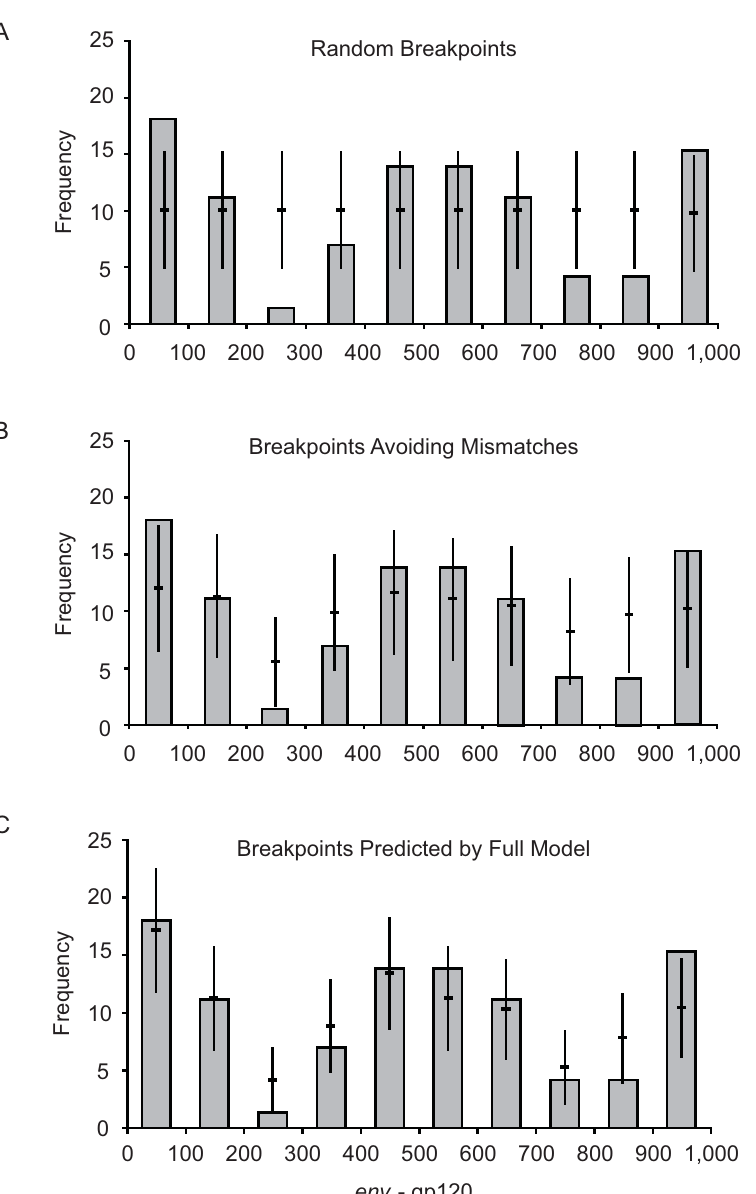
Figure 3. Testing of the recombination models. The probabilistic distribution of breakpoints as predicted by each model (horizontal lines) compared to the in vitro distribution of breakpoints (vertical grey bars). The three panels correspond to predicted breakpoint distributions that ignored sequence identity (A), prohibited a breakpoint on a mismatch (B) and the full model (C); see Methods for further details. The error bars (vertical lines) on the predicted values represent 1.96 6 standard error to include 95% of the